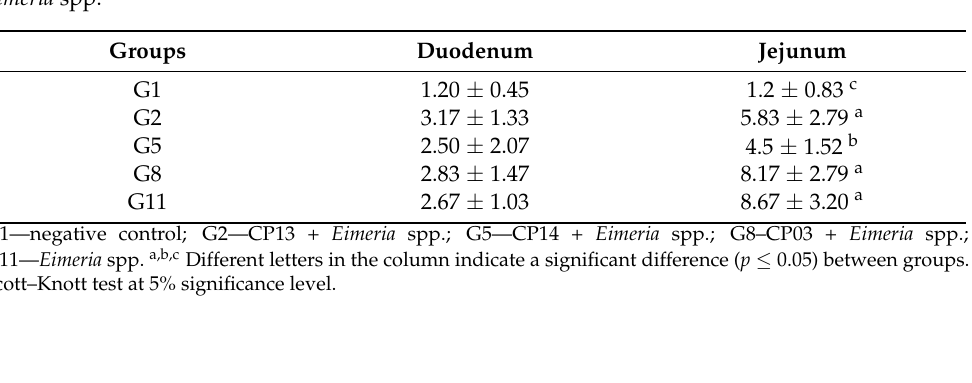
Table 5. Mean scores of microscopic lesions of the duodenum and jejunum of the groups administered Eimeria